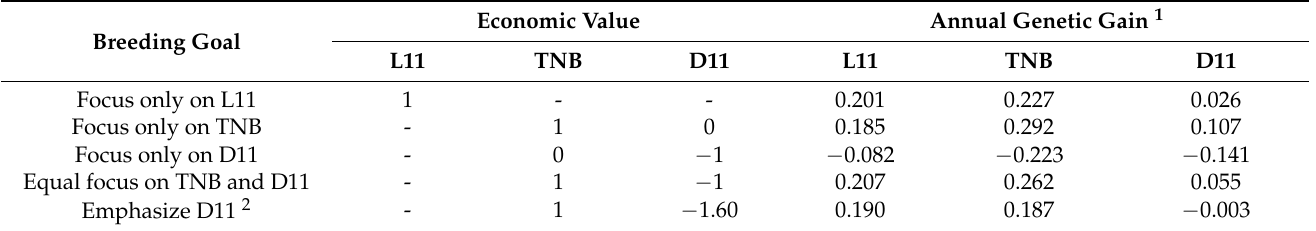
Table 2. Annual genetic gain for the number of living piglets on day 11 (L11), the total number born (TNB), and the total number of dead piglets on day 11 (D11) under different breeding goals. Economic Value Breeding Goal Focus only on L11 1 - Focus only on TNB - Focus only on D11